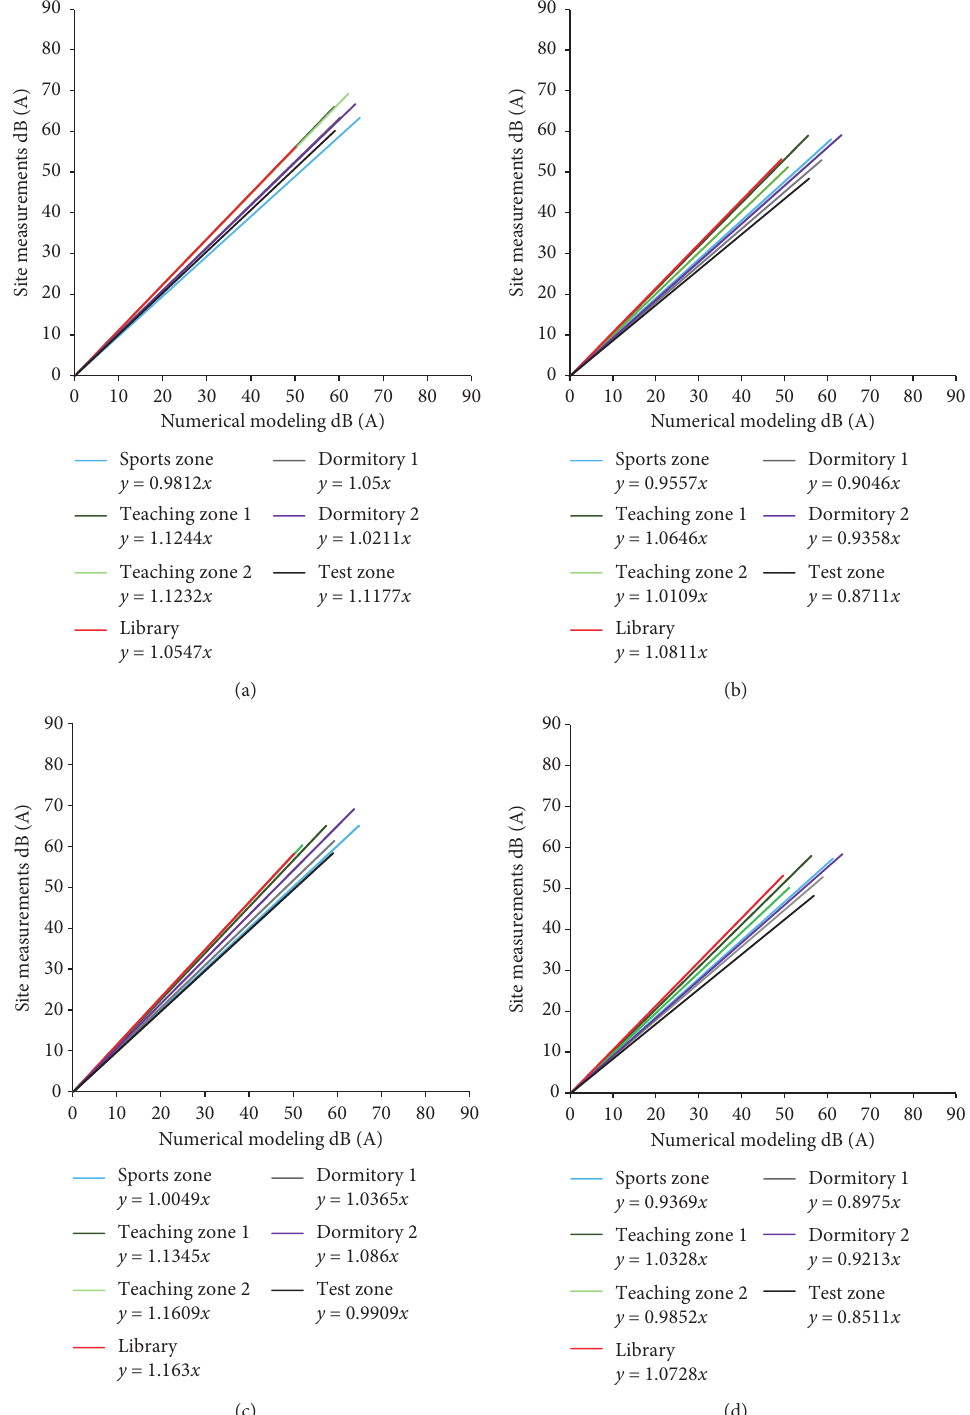
Figure 6: Theoretical curve of simulated and measured values in different time periods of each functional zone: (a) weekdays daytime, (b) weekdays nighttime, (c) weekends daytime, and (d) weekends